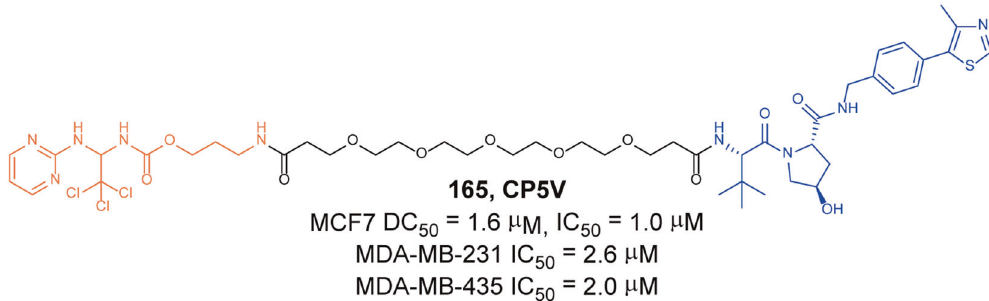
Fig. 42 The representative PROTAC targeting